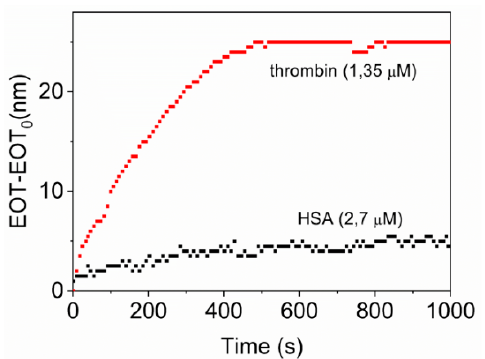
Figure 6. Optical response (EOT-EOT 0 ) after the exposure of TBA aptamer to 1.35 µM of thrombin ( red line ) and to 2.7 µg/mL of HSA ( black line ).